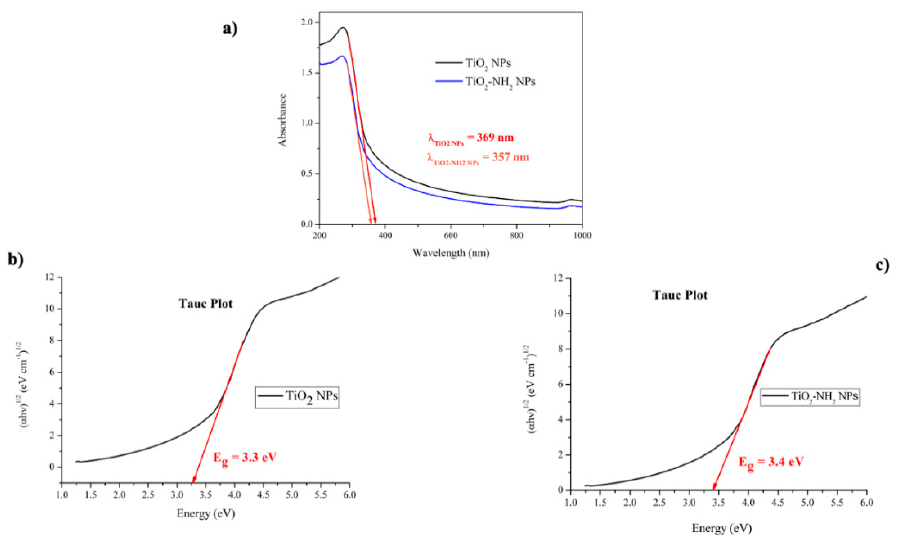
Figure 2. Bandgap energy of a-TiO 2 based NPs: ( a ) UV-Vis spectra; ( b ) Tauc’s plot of a-TiO 2 indirect band gap; ( c ) Tauc’s plot TiO 2 -NH 2 indirect bandgap.